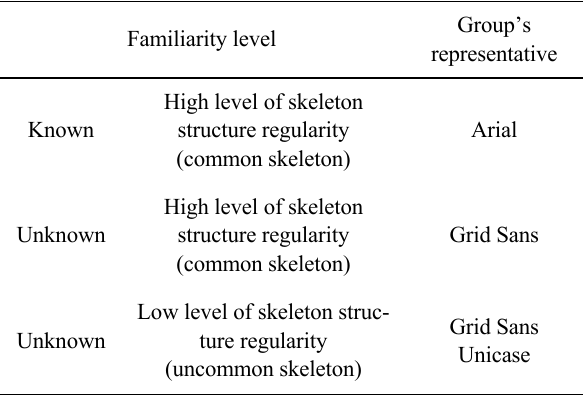
Table 1. Different familiarity levels of examined